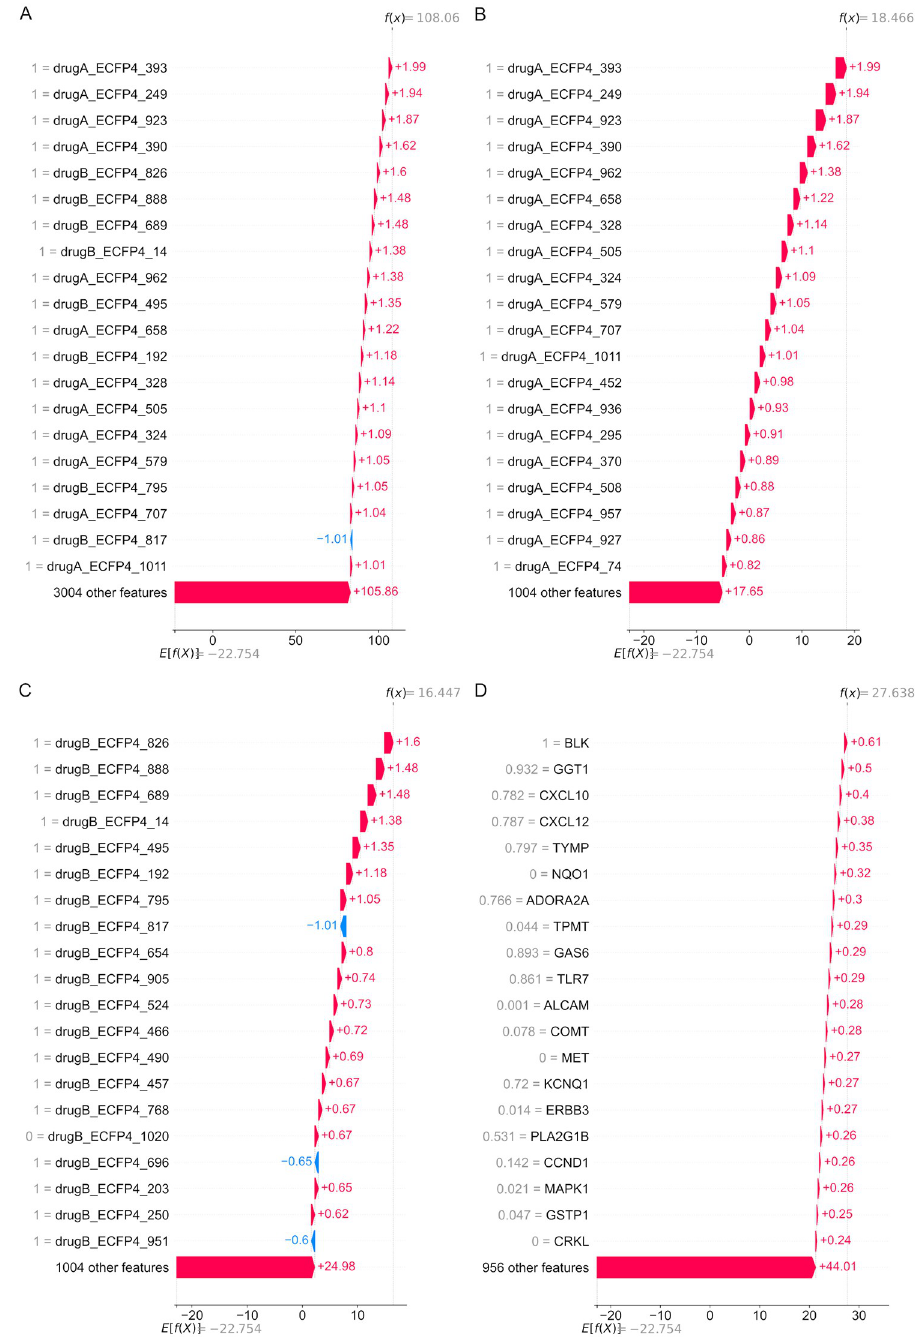
Fig 4. Most important features (ranked by absolute SHAP values) for test set example 11835, shown as waterfall plots. The plot starts at a base value of -22.754, which is the expected model output (determined based on a background dataset). Each row shows how each feature positively or negatively contributes to move the value from the expected output to the predicted value for this sample. (A) Top 20 features (from all features). (B) Top 20 drugA features. (C) Top 20 drugB features. (D) Top 20 gene expression